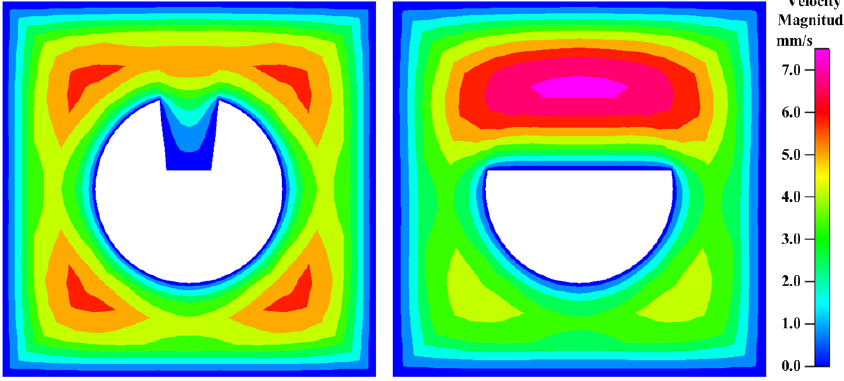
Figure 6. Contours of the flow field in the FO-LPR microfluidic chip with (left) the U-type and (right) the D-type fiber.